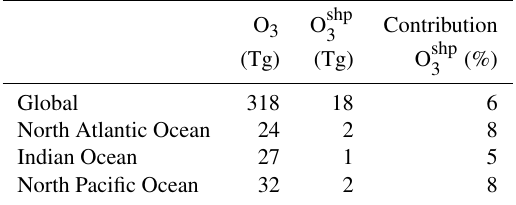
Figure 9. Zonal mean of shortwave, longwave, and net radiative O 3 forcing of (a) land transport and (b) ship traffic. The continuous Table 7. Burden of O 3 (total) and O shp (shipping) integrated up to lines give the results of the tagging method, and the dashed lines of 3 200hPa (in Tg). Average values for the period 2006–2010. the perturbation method. O 3